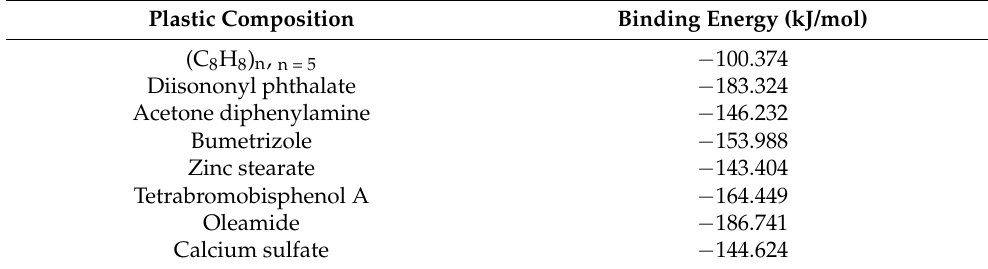
Table 4. Binding energy of Polystyrene 5 polymer and additives to plastic in the presence of break- down protein (7CC4).